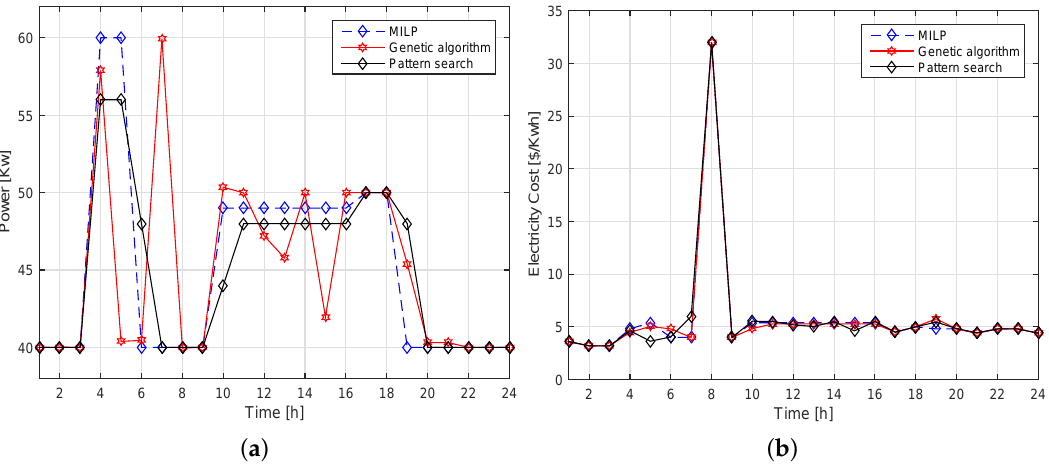
Figure 11. Comparison with power demand output by MILP solver for a single home on a day ( a ) genetic algorithm and pattern search ( b ) Cost output by MILP solver for a single home on a day ( b ) genetic algorithm and pattern search.